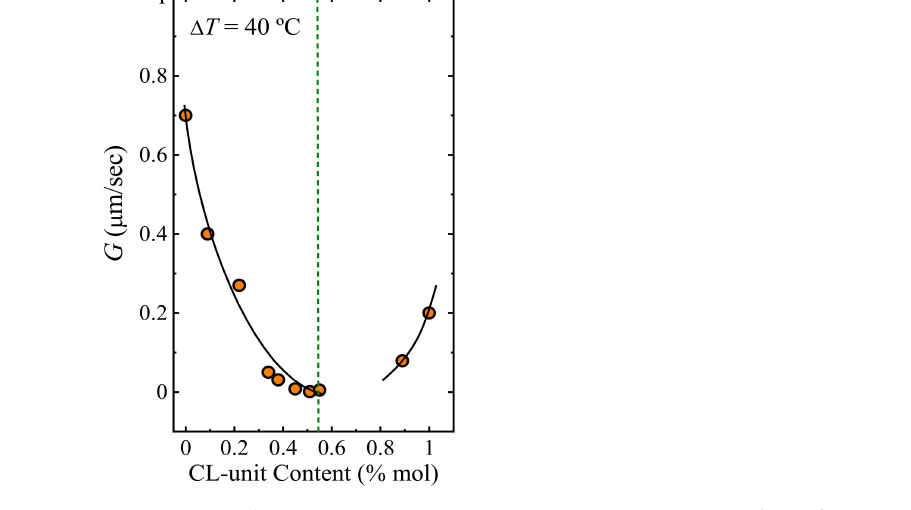
Figure 12. G values versus CL-unit content at a constant super cooling of 40 ◦ C. The black lines are polynomial fits. Data reported in ref.